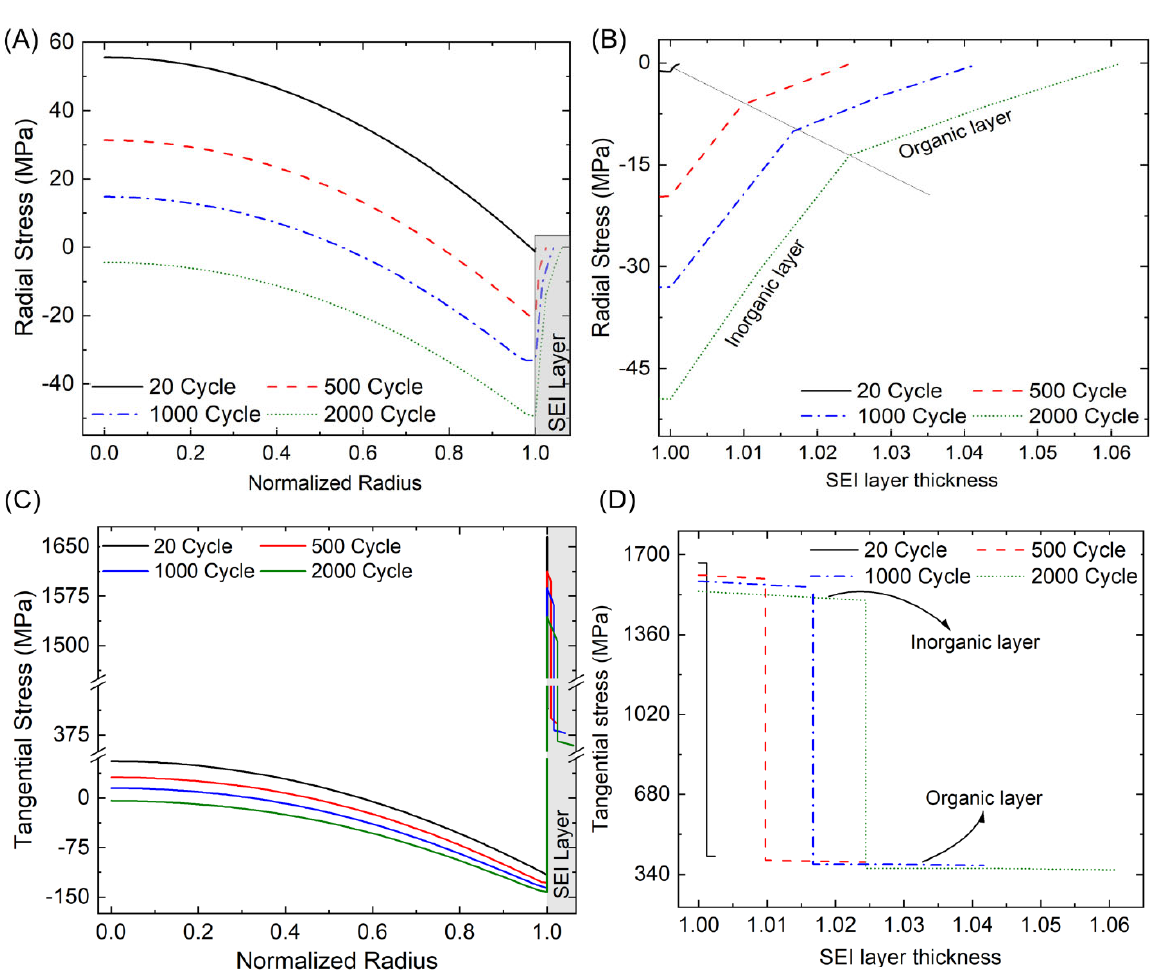
Figure 4. Evolution of radial and tangential stress inside the particle and SEI layer during lithiation. ( A ) Radial stress inside the particle and SEI layer, with ( B ) magnified view inside the inorganic and organic SEI layer. ( C ) Tangential stress inside the particle and SEI layer, with ( D ) magnified view inside the inorganic and organic SEI layer.